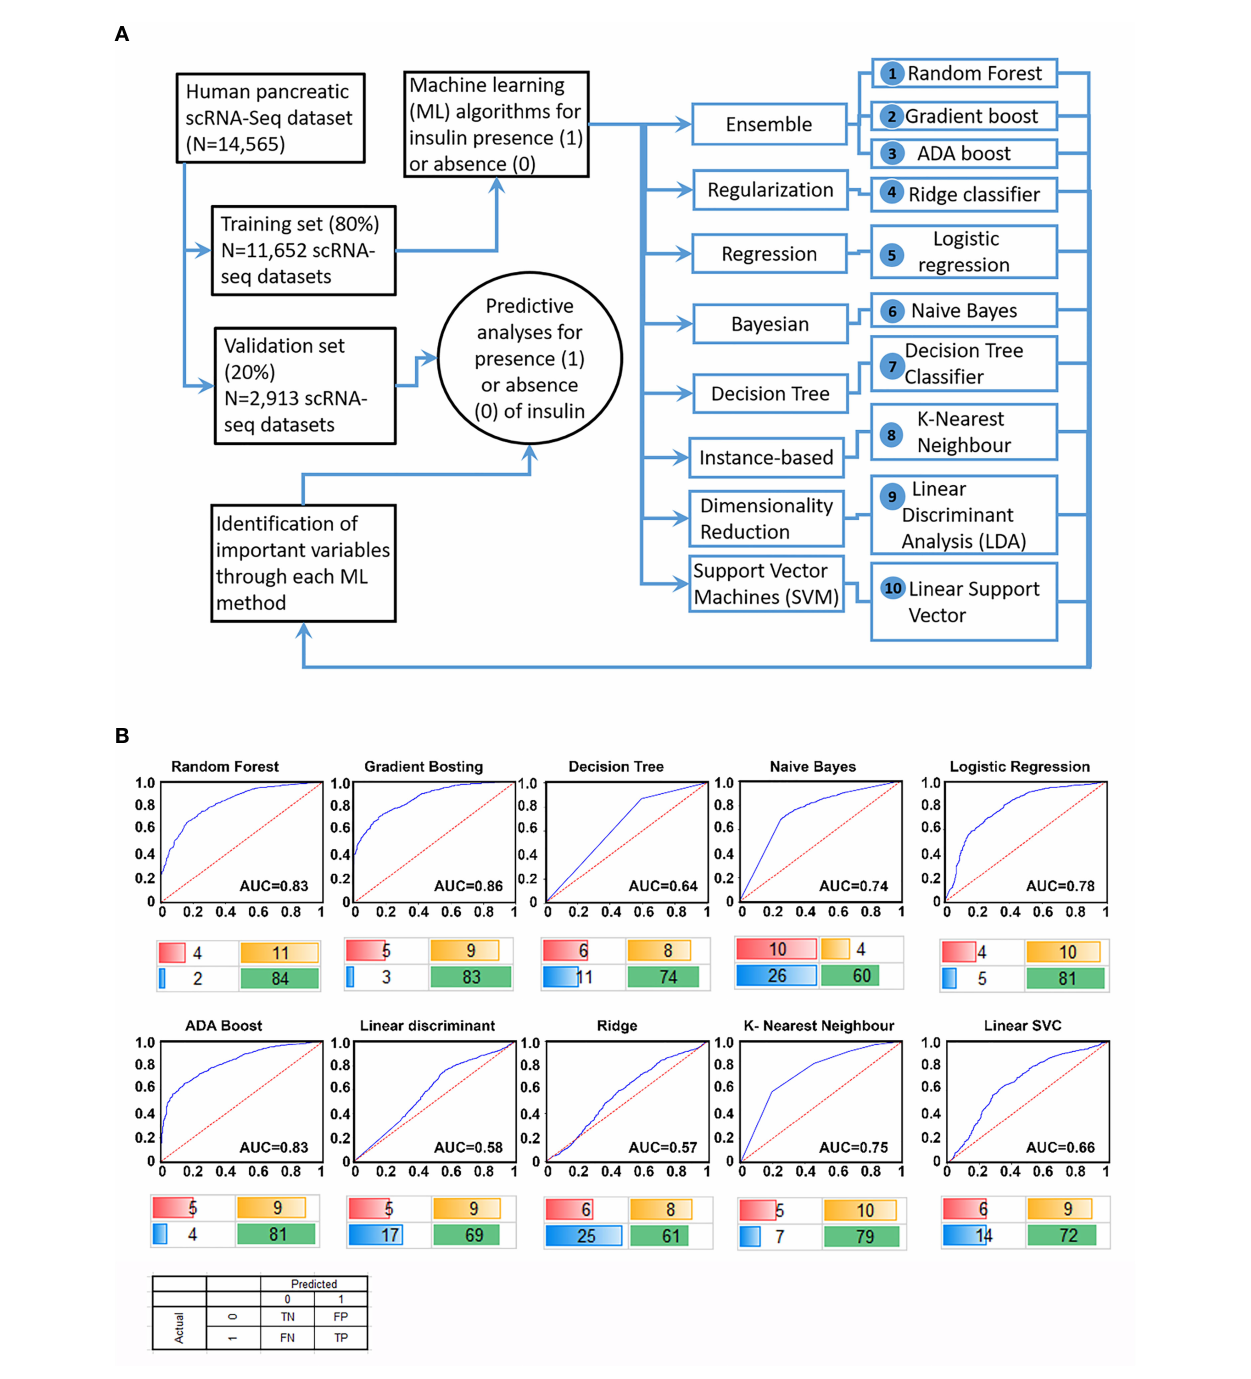
FIGURE 1 | Study design and performance of different ML work fl ows. A fl owchart of our analytical plan is presented in (A) . Previously published datasets of single- cell RNA-sequencing analyses from pancreatic islet cell preparations were randomly divided into a training (N = 11,652) and a validation (N = 2,913) set. The learning phase (Training) involved identifying features (genes) and their associated weights/coef fi cients in each of the 10 machine learning (ML) methods (listed 1-10). Weighted features were used in the prediction of insulin transcription (across 10 ML algorithms) to test the performance of these models in an independent validation set of samples (N = 2,913). ROC curve plots for each ML algorithm using validation set data are presented in (B) . The area under the curve (AUC) for the tested work fl ows are presented along with a confusion matrix below the plot. Percent values are rounded off to the nearest integer (and hence may not sum up to an absolute 100%) and represent true negative (red), true positive (green), false positive (yellow) and false negative (blue) samples identi fi ed in the validation